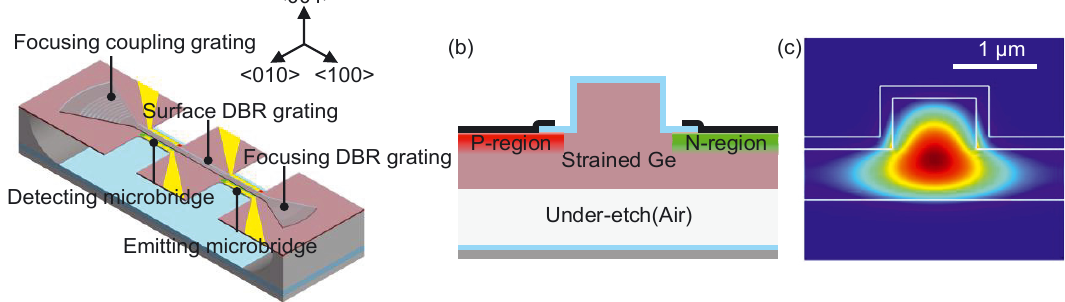
Figure 1: (a) Schematic of the double strained-microbridge cascaded emitting-detecting configuration (not to scale). (b) Sectional view of the suspended Ge microbridge. (c) Fundamental TE mode